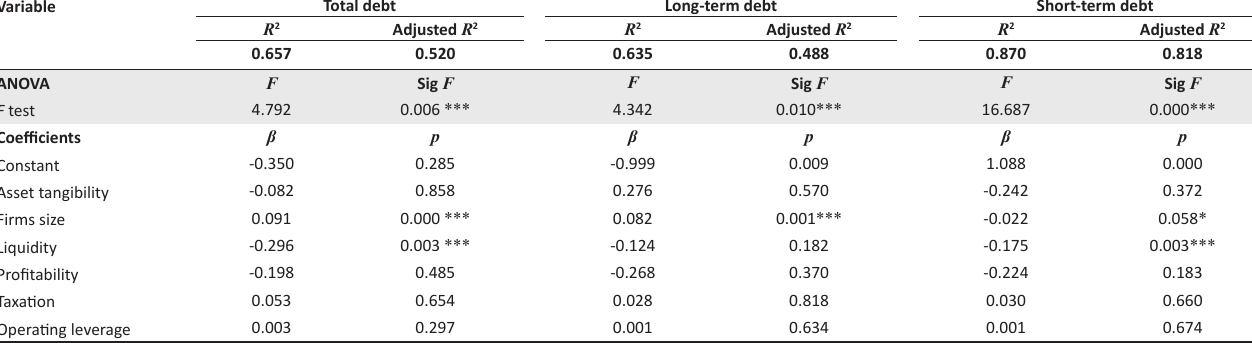
TABLE 8: Regression coefficients – Consumer goods sector (1994–2015).